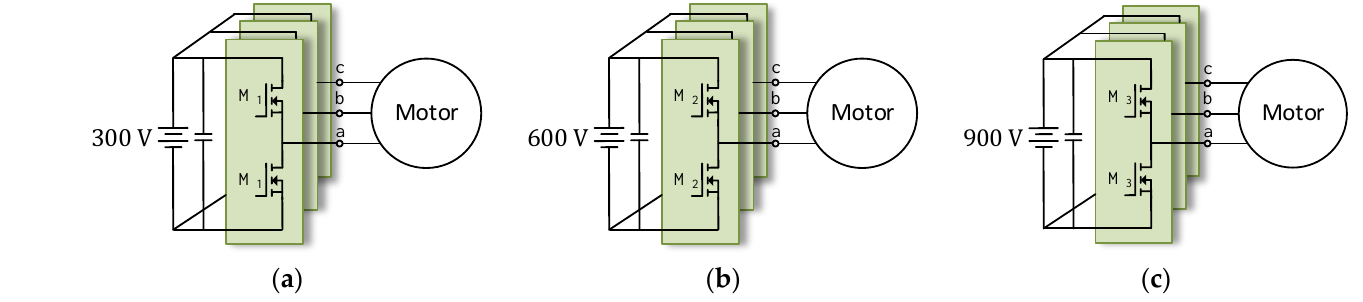
Figure 1. Design A. ( a ) EV 1 . ( b ) EV 2 . ( c ) EV 3 (for the sake of simplicity, the diodes in antiparallel with the MOSFETs have been intentionally omitted).